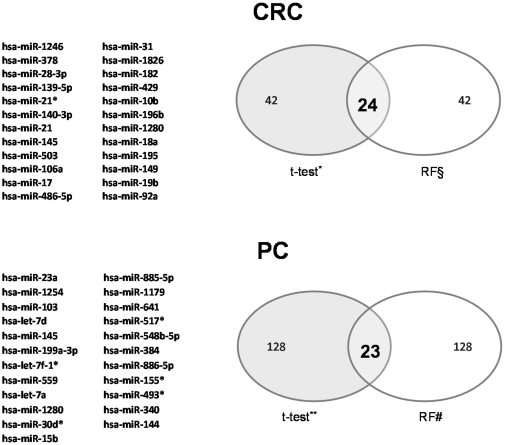
Merged results.For both tissues a significant overlap among detected miRNAs was found by merging t-test and RF results. A group of 24 miRNAs, whose expression was significantly altered in colorectal tumors, were obtained intersecting the list of first 42 miRNAs with best p-values, from t-test analysis, with those at highest MDA, from RF analysis. In the same fashion, 23 miRNAs with altered expression were selected in pancreatic tumors. * p<0.001; § RF>4.3; **p<0.05; # RF>0.94.